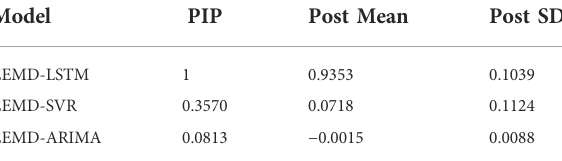
TABLE 3 Results of EEMD-BMA